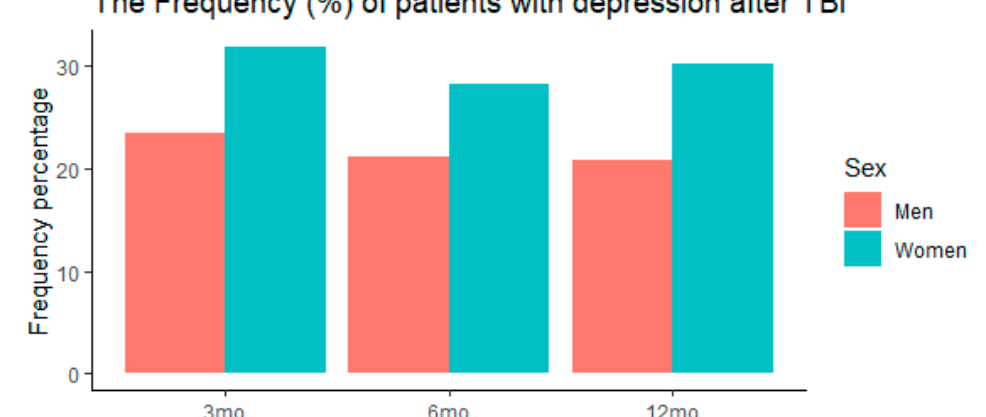
Table A4. The cross-table of depression and anxiety categories (cut-off point of 8).